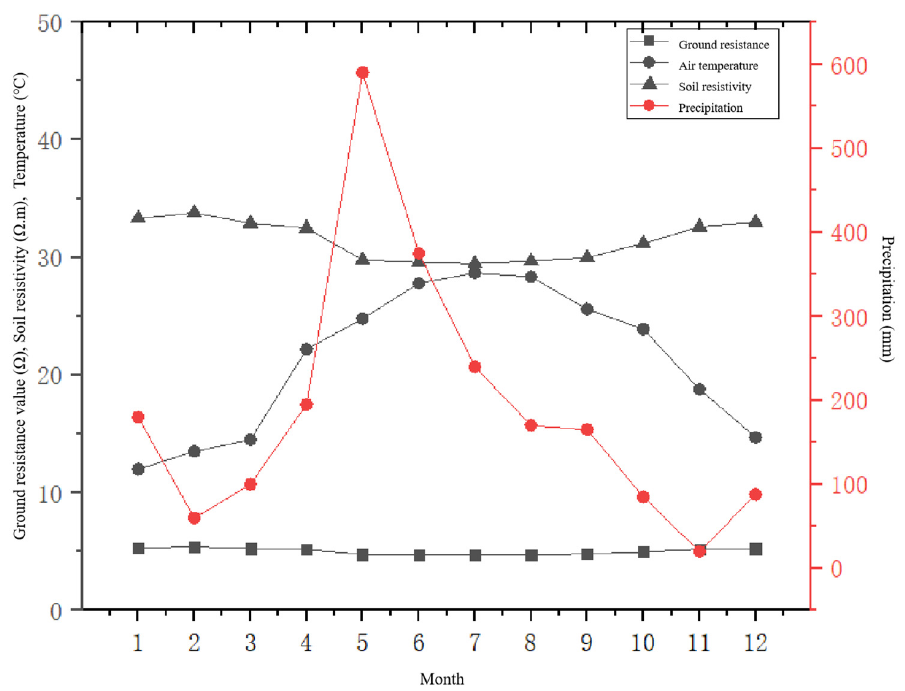
Figure 8. Monthly variation relationships between earth resistance and soil resistivity, temperature, and precipitation.